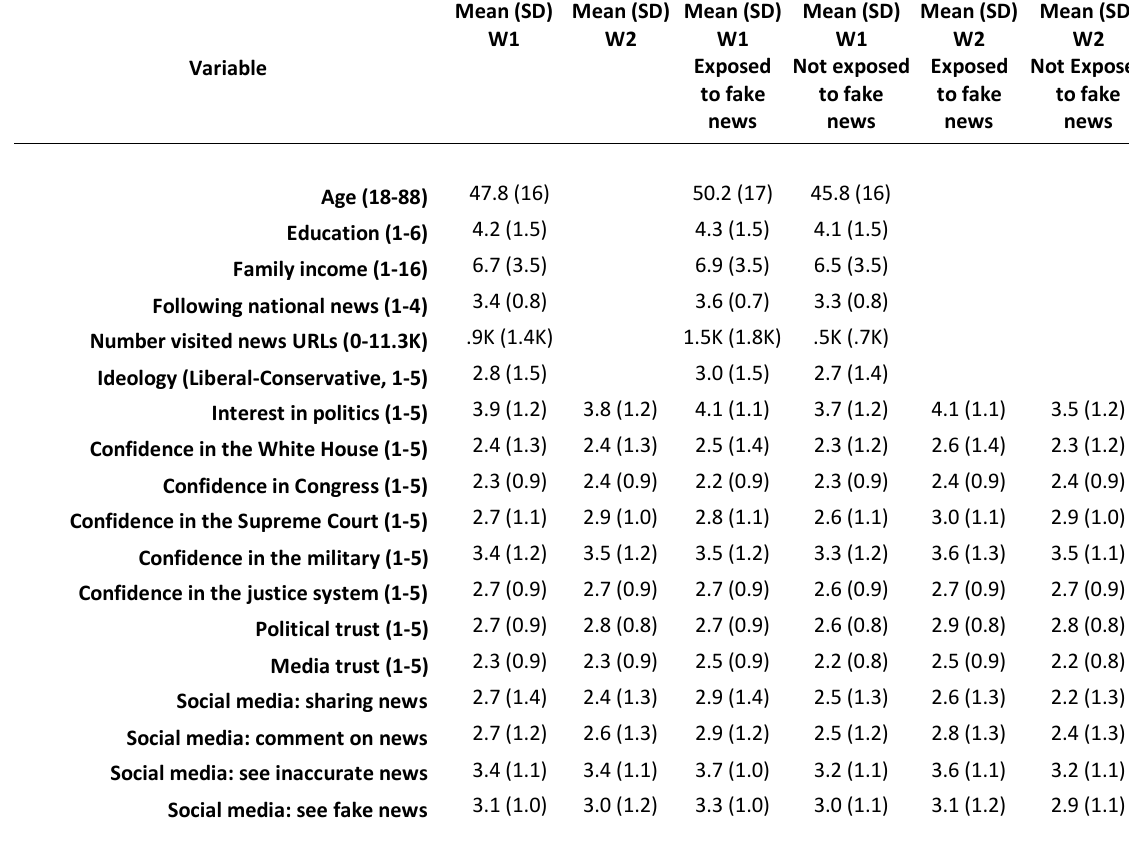
Table A2. Key variables - descriptive